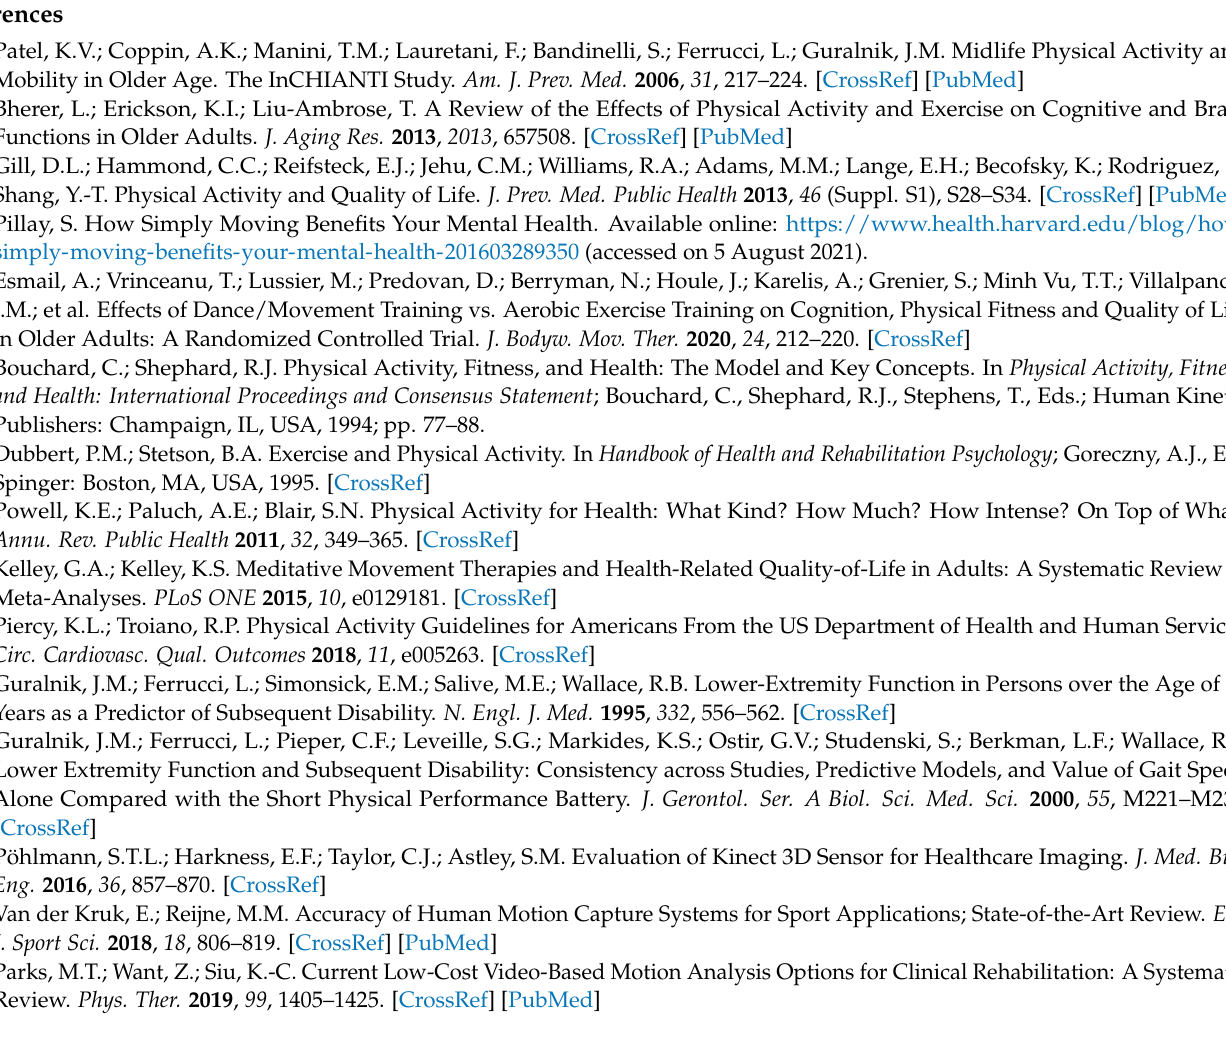
Figure S2: Inter-target resolution in meters; Figure S3: Effect of luminosity on target detection resolution in